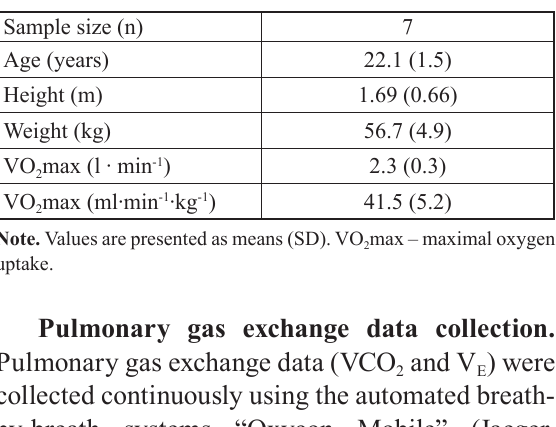
Table 1. Physical and aerobic capacity characteristics of